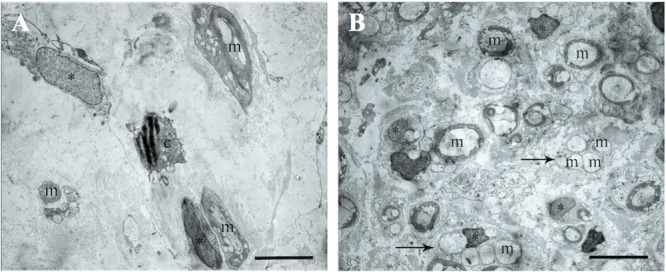
The transmission electron microscopic examination of the distal segment of the right and left sciatic nerve. (A) Tissue samples with insert (control group): m- myelin fibers, ∗ – nuclei of Schwann cells, light background – connective tissue, c – cells with signs of degeneration, m – myelin fibers. Bar: 5 μm. (B) Tissue of the left sciatic nerve samples: m – myelin fibers, ∗ – nuclei of Schwann cells, pointer – bundles of myelinated and unmyelinated fibers, n – cell nuclei. Bar: 5 μm.